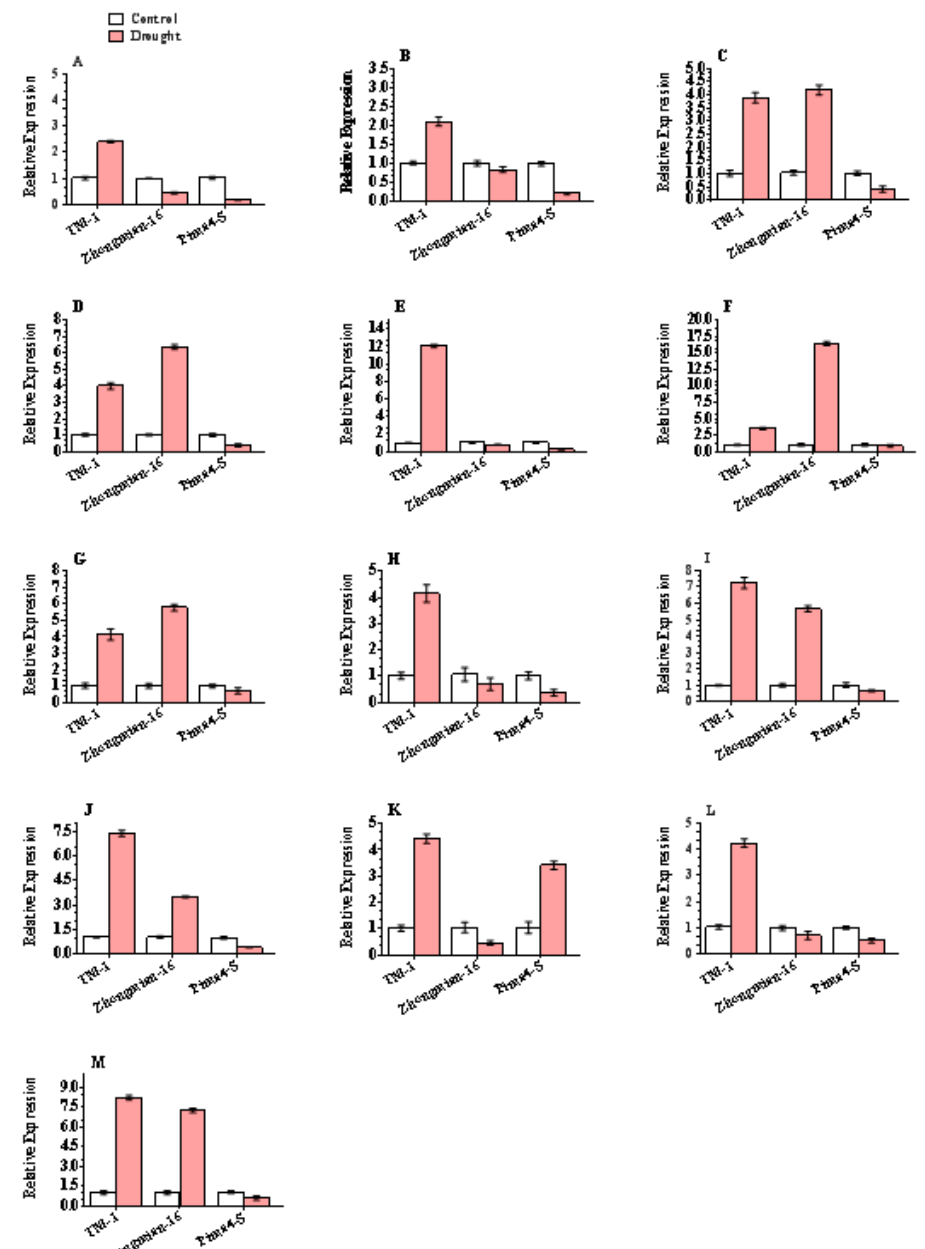
Figure 6. Relative abundance of selected transcripts as determined by qPCR. Expression profiling of selected 13 DEGs were performed using quantitative real time PCR. Here, ( A ) indole-3-acetic acid-amidosynthetase GH3.17, ( B ) ribulose bisphosphate carboxylase / oxygenase activase 2% 2C chloroplastic, ( C ) transcription factor HEC2 , ( D ) glucan endo-1% 2C 3-beta-glucosidase 5, ( E ) inositol oxygenase 1, ( F ) probable trehalose-phosphate phosphatase D, ( G ) protein DETOXIFICATION 49, ( H ) 21 kDa, ( I ) pectinesterase, ( J ) arginine decarboxylase, ( K ) leucine-rich repeat receptor protein kinase PXC2 , ( L ) secoisolariciresinol dehydrogenase, and ( M ) thaumatin protein genes in the leaves of three cotton species, TM-1, Zhongmian-16, and Pima4-S, are presented. The relative abundance (Y-axis) was calculated using the 2 − ∆∆ C t method. Three cotton species seedlings were subjected to drought stress. The mean of three independent biological replicates is presented.